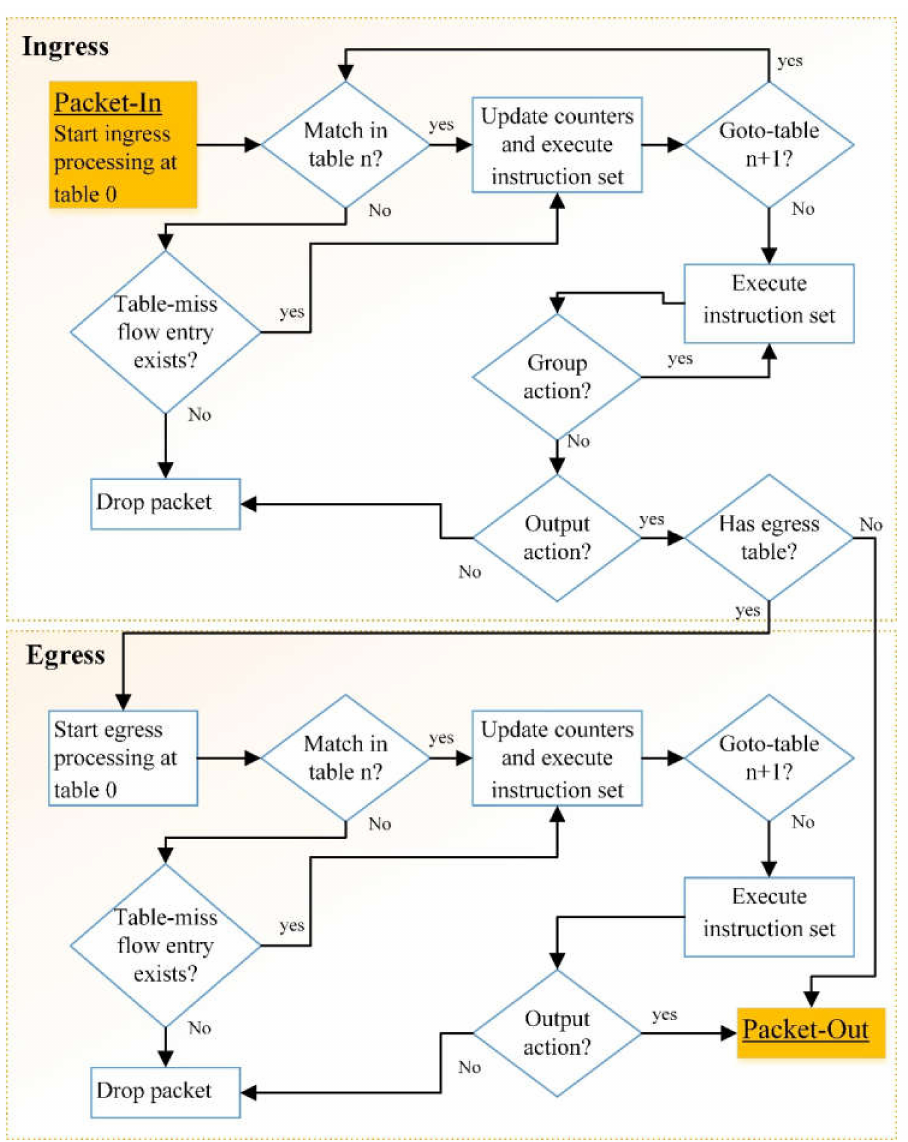
Figure 4. Flowchart showing details of packet flow via OpenFlow SDN-Switch